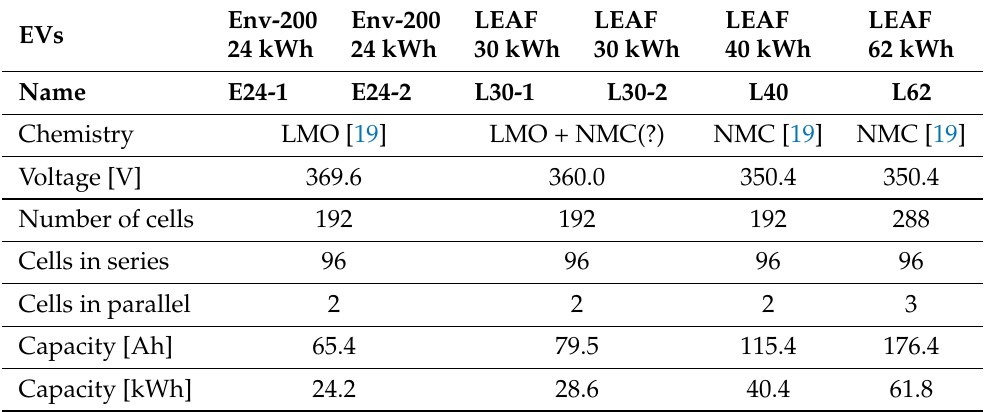
Table 1. Vehicles’ battery pack and cell characteristics. The number next to E and L indicates the nominal capacity in kWh.